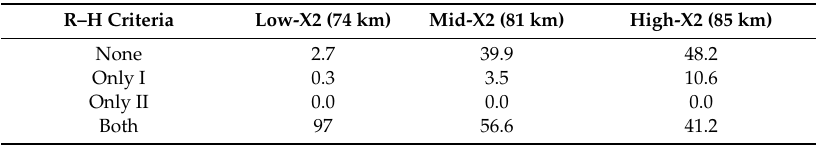
Table 2. Percent of quantitative community models meeting zero, one and both Routh–Hurwitz (R–H) stability criteria at three X2 positions in the low salinity zone of the upper San Francisco Estuary (based on 10,000 simulations at each X2